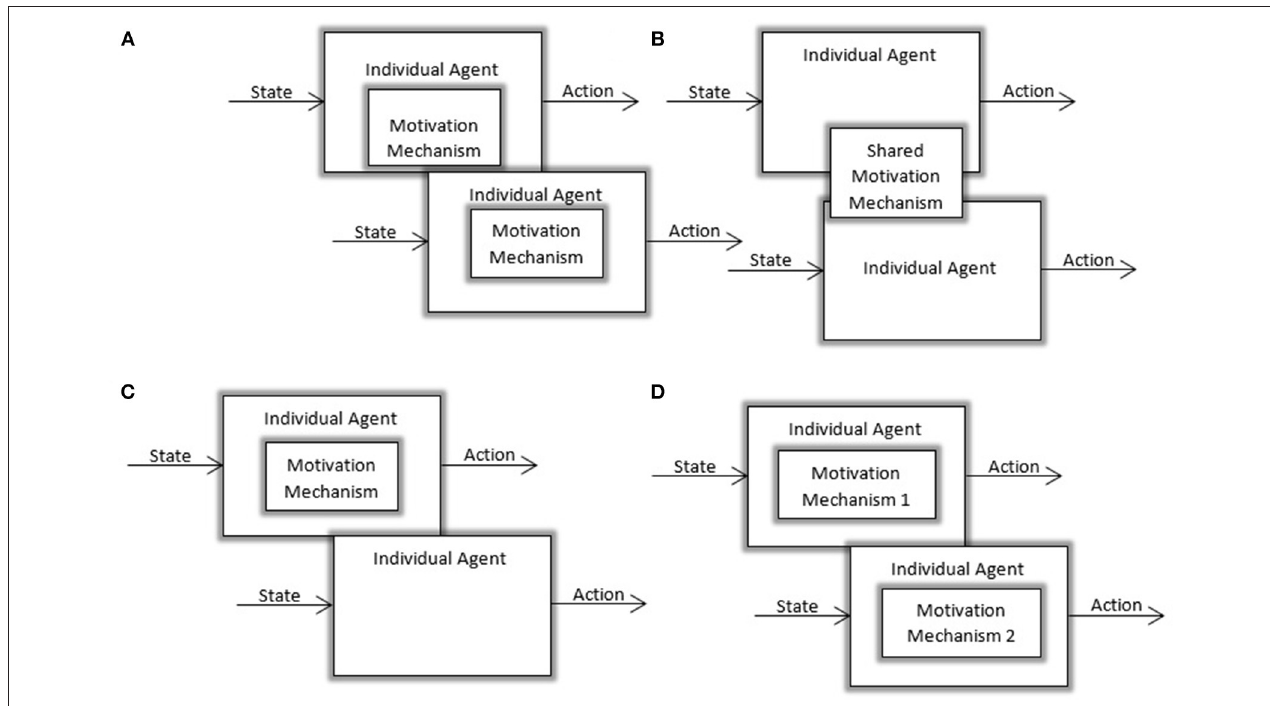
FIGURE 3 | Visualization of different possible multi-agent settings: (A) Multi-agent setting with homogeneous agents and decentralized motivation mechanisms (B) Multi-agent settings with homogeneous agents using a centralized motivation mechanism (C) Heterogeneous society with a subset of motivated agents (D) Heterogeneous society with agents using different motivation